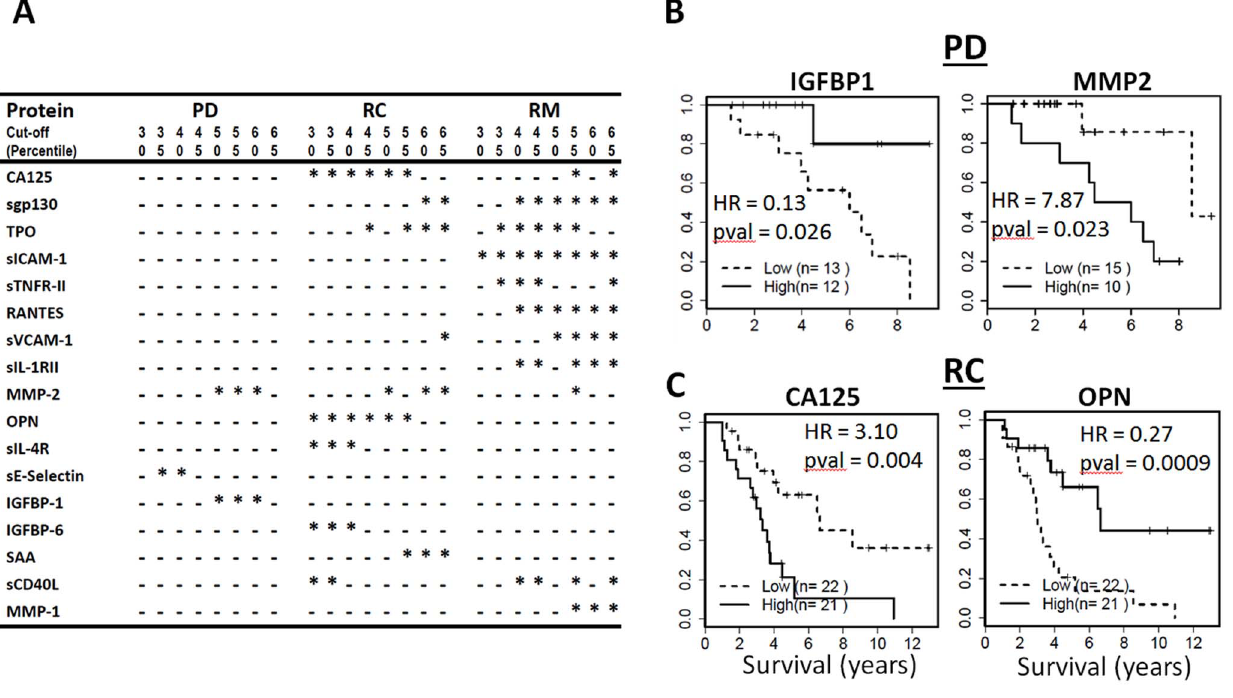
Figure 4. Survival analyses of ovarian cancer patients. Kaplan-Meier analysis was used to investigate the relationship of individual protein levels on overall survival in three different phenotypic groups (PD, RC, and RM). A: The subjects were assigned to the low or high expression groups based on the protein expression for each protein. As the best cutoff points were not known, we systematically evaluated eight cut-off points ranging from 30th percentile to 65th percentile of expression values. Each star (*) represents a significant difference in the overall survival of low expression and high expression groups. B: Survival curves of the samples from the PD stage. Only four proteins showed marginally significant associations with